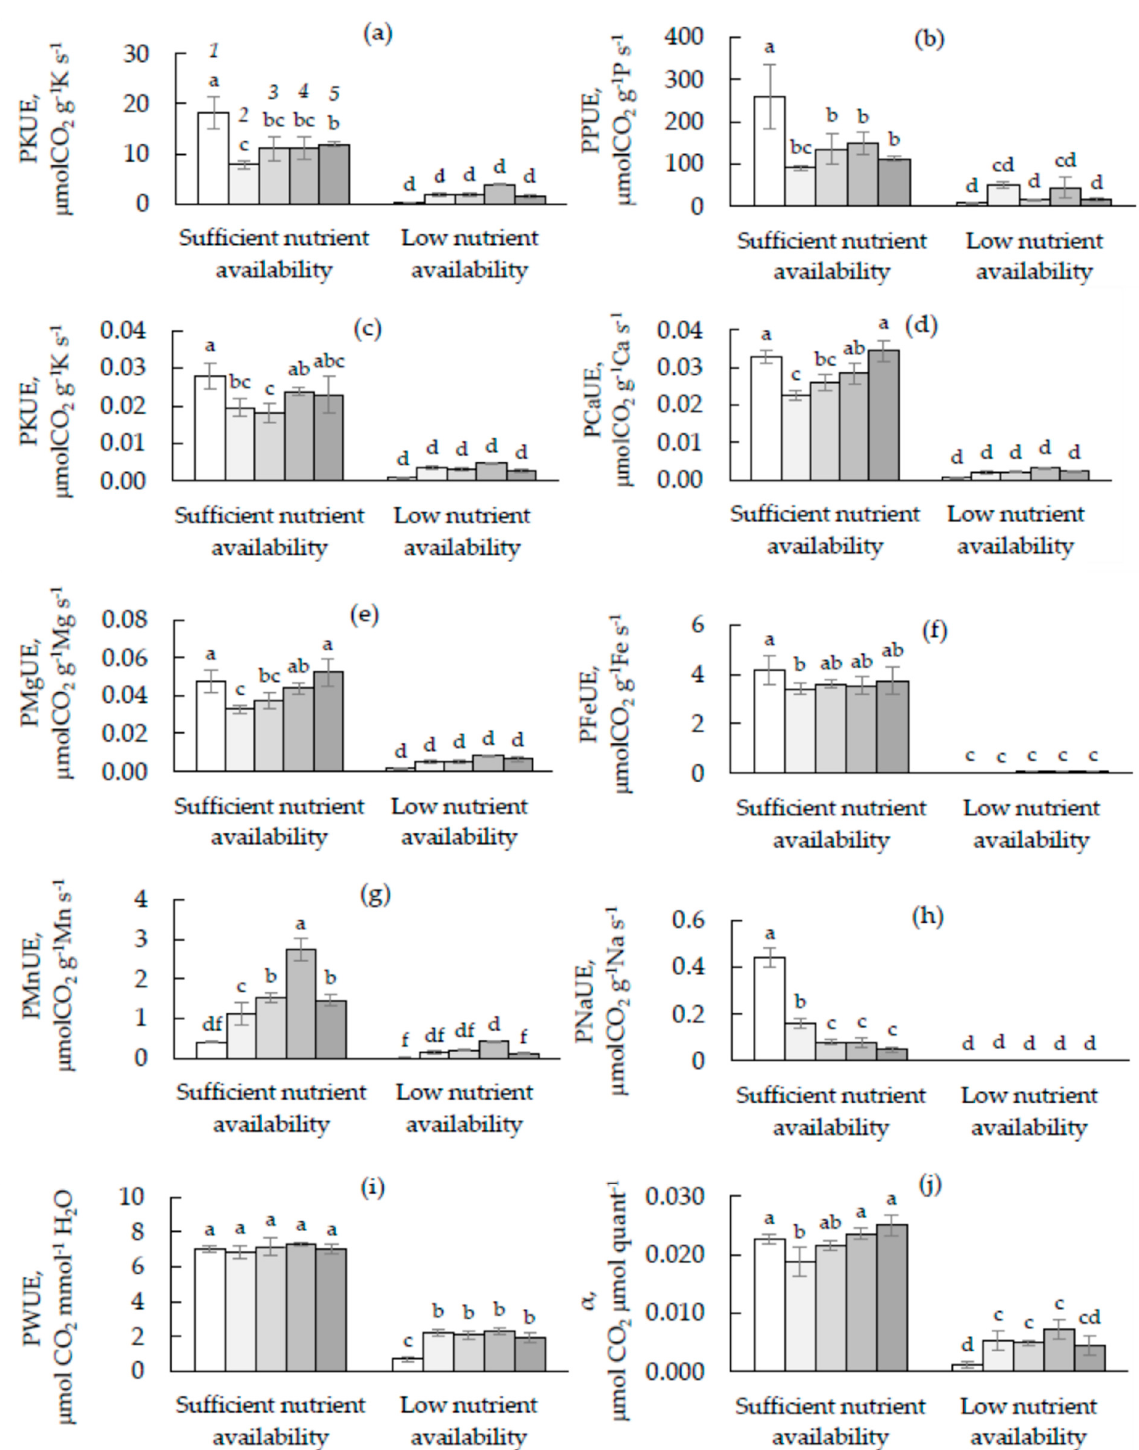
Figure 1. Photosynthetic nitrogen (PNUE, a ), phosphorus (PPUE, b ), potassium (PKUE, c ), calcium (PCaUE, d ), magnesium (PMgUE, e ), iron (PFeUE, f ), manganese (PMnUE, g ), sodium (PNaUE, h ), water (PWUE, i ), and light ( α , j ) use efficiency for cucumber seedlings grown in the soil with a lignosulfonate concentration of 0 ( 1 ), 1 ( 2 ), 2.5 ( 3 ), 5 ( 4 ), and 10 ( 5 ) % under conditions of sufficient or low nutrient ability. Different letters indicate significant differences at p < 0.05.